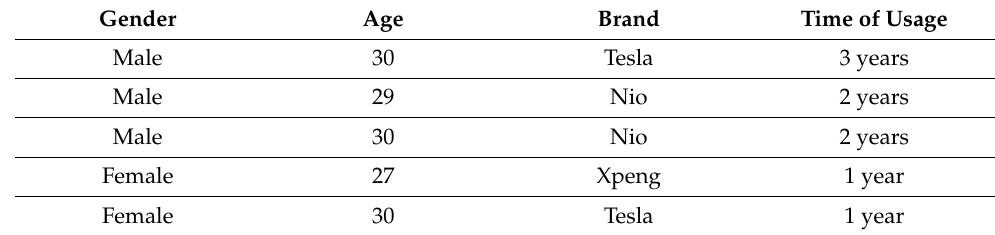
Table 1. Basic information of